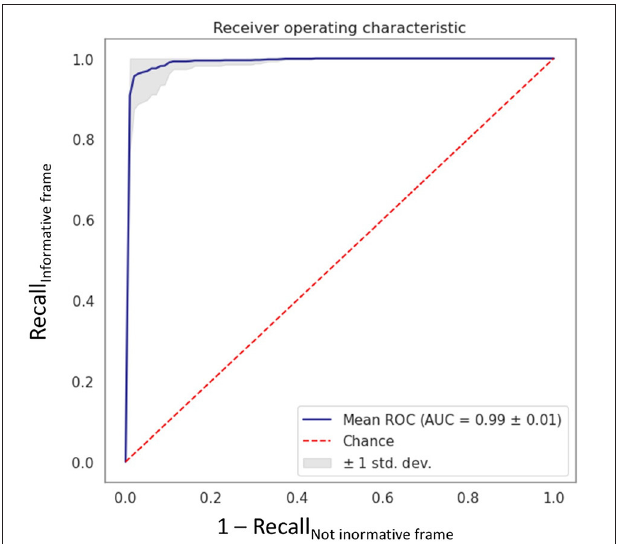
FIGURE 3 | Receiving operating characteristic curve obtained with the fine-tuned VGG16 CNN algorithm “MHC identifier 1.” AUC, area under the curve; ROC, receiving operating characteristics; std dev, standard deviation.